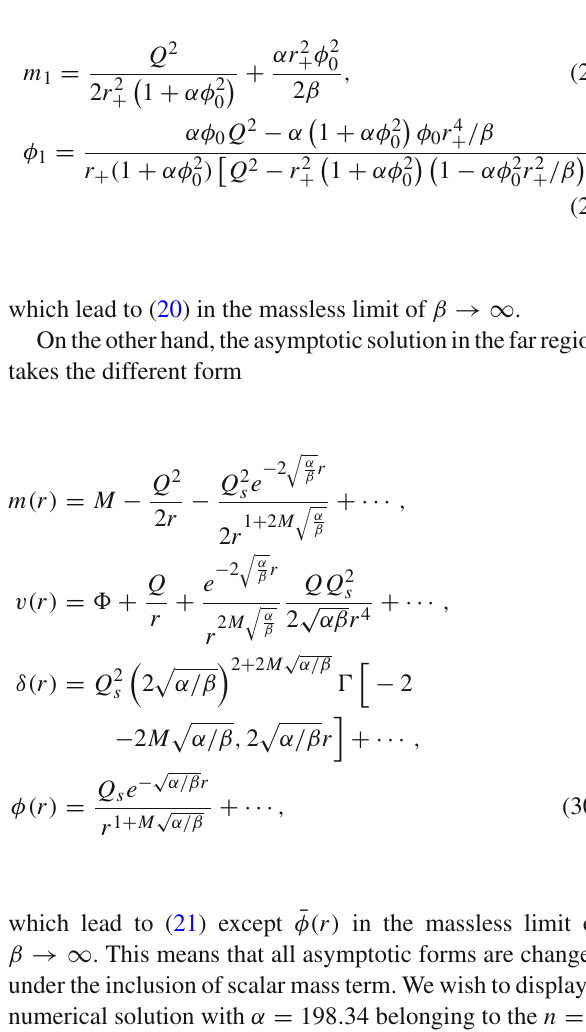
Fig. 4 A 3D graph of function g ( r ,α) for r ∈ [ r + = 1 . 995 , 200 ] and α ∈ [ 0 . 01 , 20 , 000 ] . Its minimum stays near r = r + = 1 . 9943 as α increases. The gray strip along the r -axis indicates negative region of g ( r ,α) and so, it is excluded from consideration